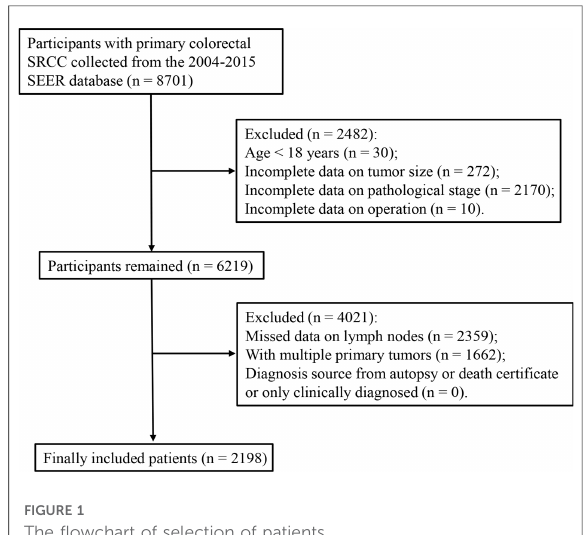
FIGURE 1 The fl owchart of selection of